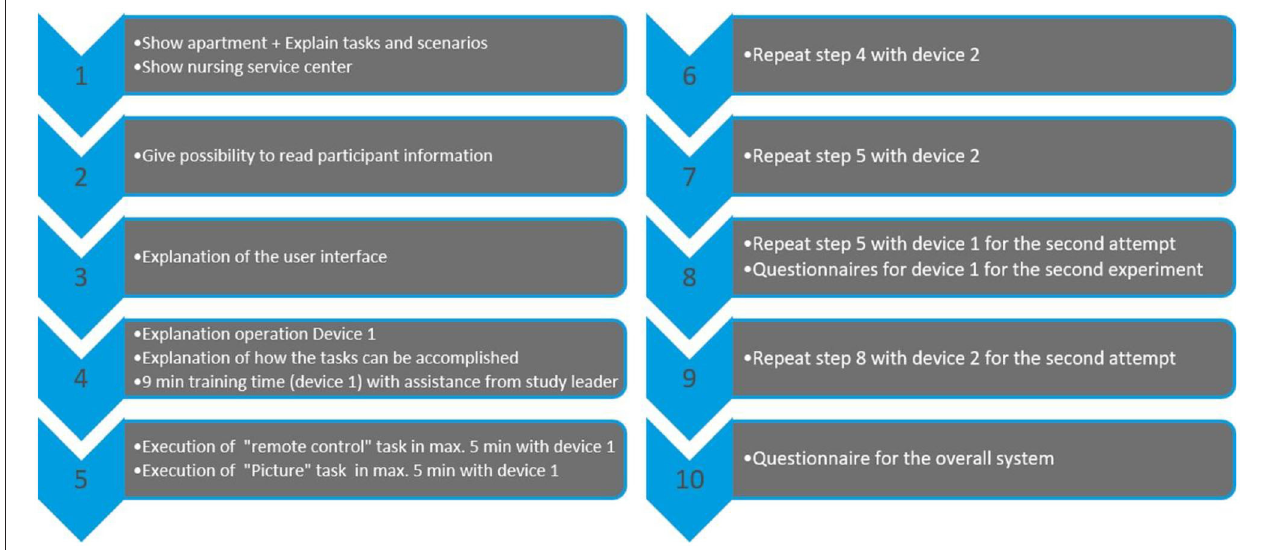
FIGURE 7 | Procedure of the study for one subject: Study procedure for one participant: After an introduction phase to the system (steps 1 to 3), the actual conduct of the study begins in two rounds (round 1 is steps 4 to 7, round 2 is steps 8 and 9). In each round, both input devices are used in random order. The study is completed with step